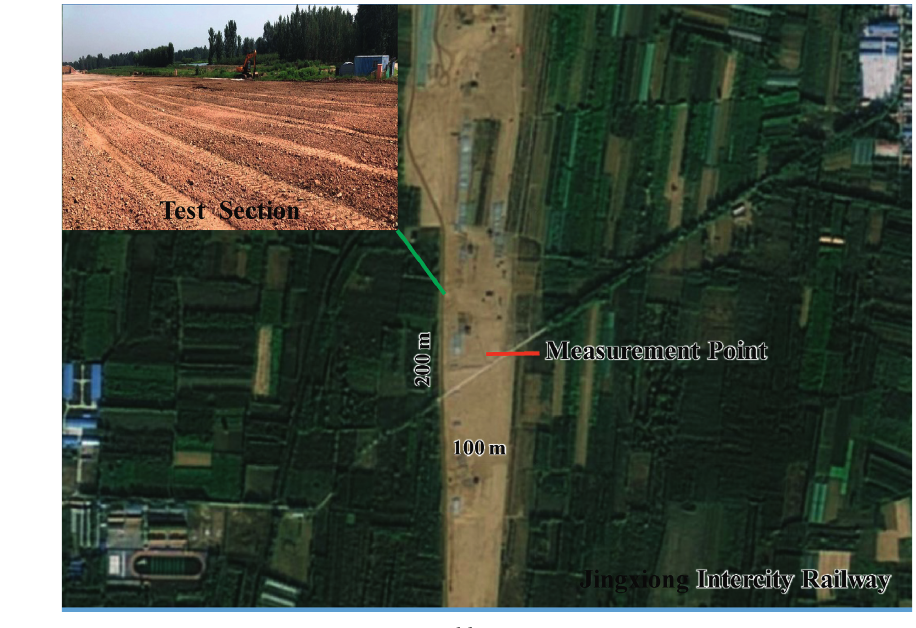
Figure 3: Field test environment.